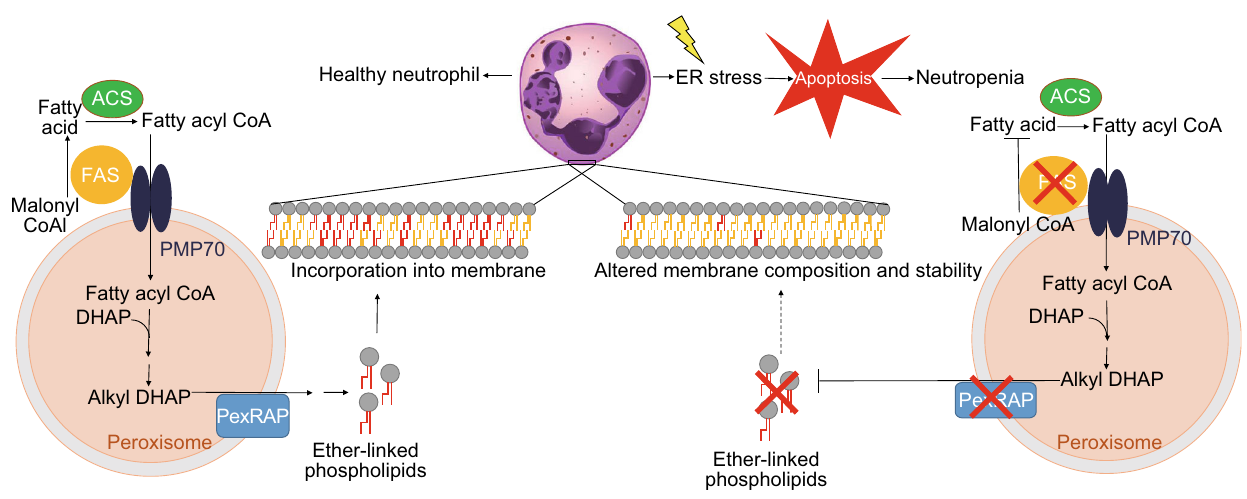
Figure 3. Peroxisomal lipid synthesis is required for maintaining neutrophil viability and membrane integrity. In healthy neutrophils, fatty acid synthase (FAS) and PexRAP participate in peroxisomal lipid synthesis, including the generation of ether-linked phospholipids that are incorporated into the plasma membrane, contributing to membrane integrity. Genetic ablation of FAS or PexRAP disrupts the lipid synthetic pathway, leading to a preferential loss of ether-linked phospholipids in neutrophils. This alters membrane stability, leading to the activation of ER stress, increased apoptosis, and